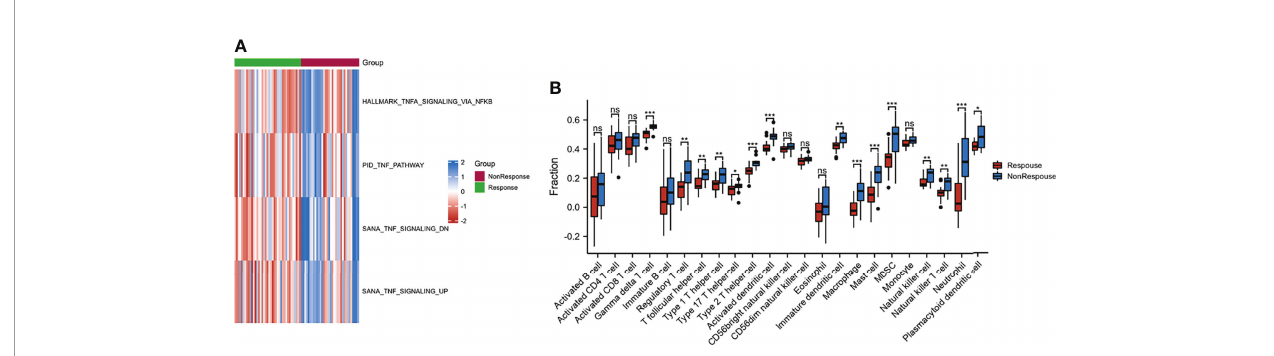
FIGURE 1 | Characteristic of response and non-response to anti-TNF therapy in patients with CD. (A) GSVA of TNF-related pathway between response and non- response groups; blue and red represent activated and inhibited pathways, respectively. (B) In fi ltration fraction of immune cell in response and non-response patients (*p < 0.05, **p < 0.01, and ***p < 0.001; ns, not signi fi cant).